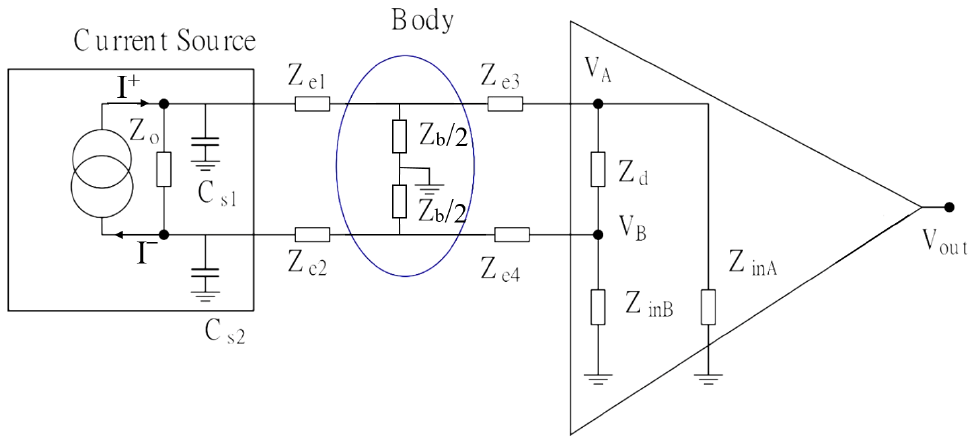
Figure 3. Parasitic impedance of the excitation and measurement system, where V out = G . ( V A − V B ) and G is the voltage gain of the instrumentation